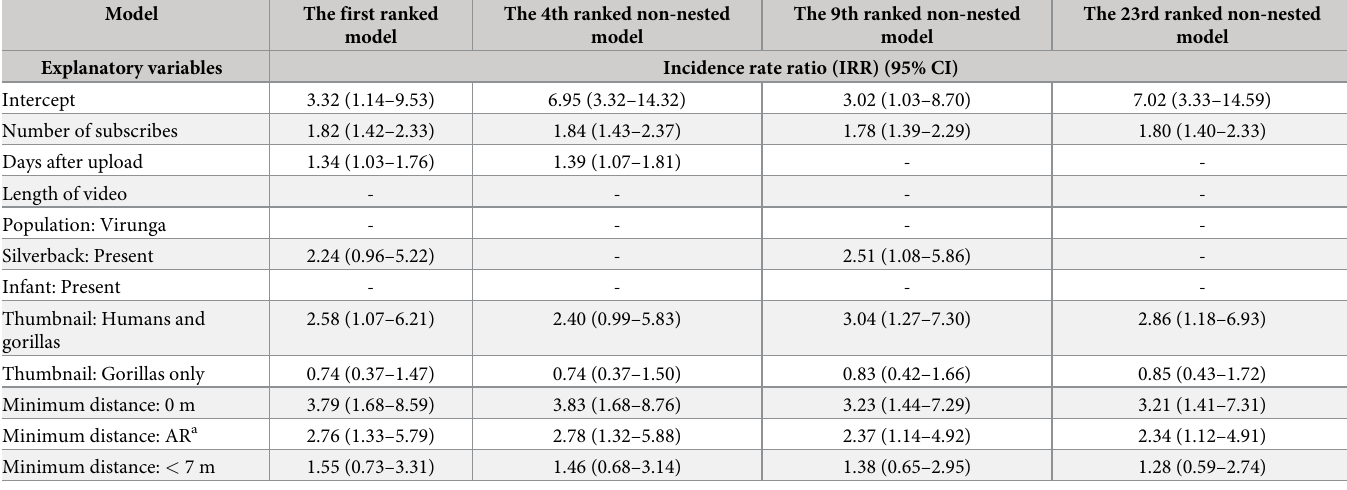
Table 4. Summary of the models exploring the factors that affect the number of views and likes of YouTube videos related to mountain gorilla tourism (N = 206). The incidence rate ratio (IRR) and 95% confidence interval (CI) of each explanatory variable in the first ranked model and non-nested models are shown.